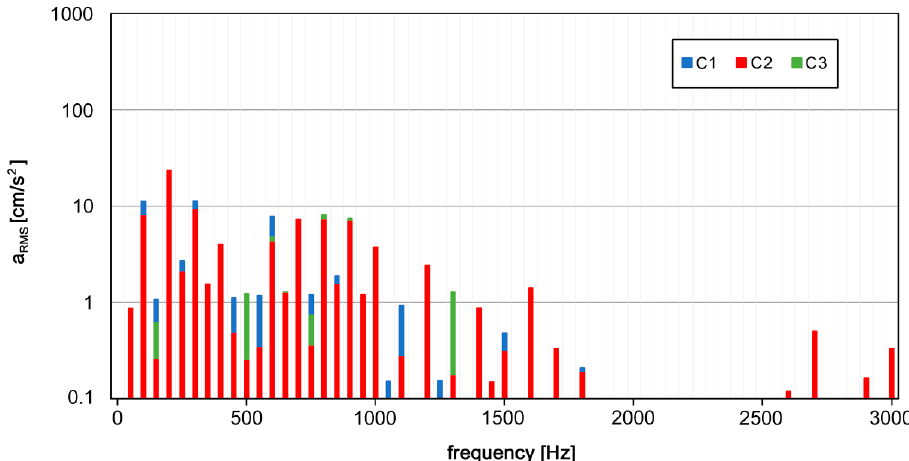
Figure 5. Comparison of the values of the dominant components of the frequency spectrum of trans- former No. 8 (16 MVA) in the range from 0 Hz to 3 kHz for different sensor locations (according to Figure 3a).